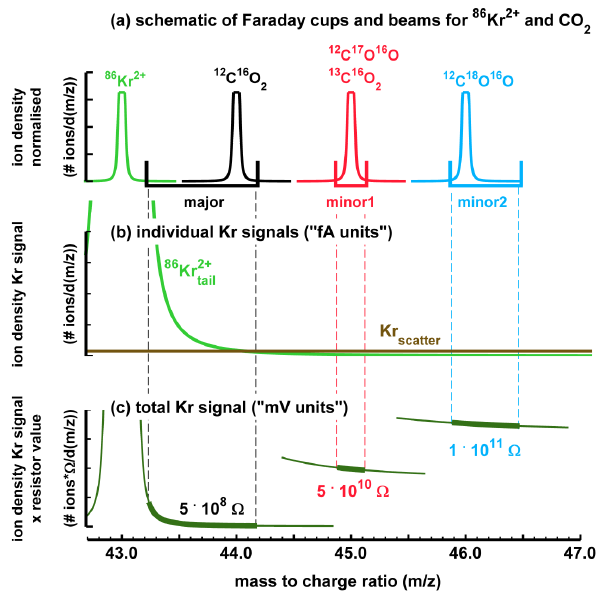
Fig. 7. Schematic showing the Faraday cups and the involved ion beams of CO 2 and the contribution from Kr to help visualise the observed Kr interference during δ 13 C analysis as observed with the Bern IRMS. (a) Estimated positioning and width of the Faraday cups and the position of the respective ion beams ( m/z ) of the CO 2 isotopologues and 86 Kr 2+ . (b) Individual contributions from Kr. To illustrate the tailing of the m/z 43 86 Kr 2+ beam ( 86 Kr 2+ tail , light green) into the major cup, an artificial density distribution is used to provide a reasonable lateral distribution. The broad, unspecific part of the Kr interference, Kr scatter , is illustrated by a brown horizontal line. (c) The sum of the two Kr contributions is plotted in dark green, but ion densities were converted to a mV unit using the respective values of the feedback resistors of the Bern Isoprime machine; the thick line represents that part of the continuous beam which becomes finally collected in the respective Faraday cups (vertical dashed lines mark the geometric limits of the Faraday cups as a visualisation of the spatial integration of the Faraday cup).